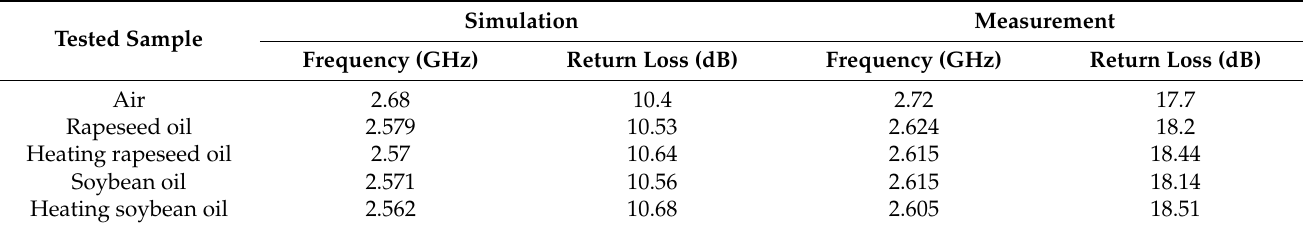
Table 3. Comparison of sensor simulation and measurement